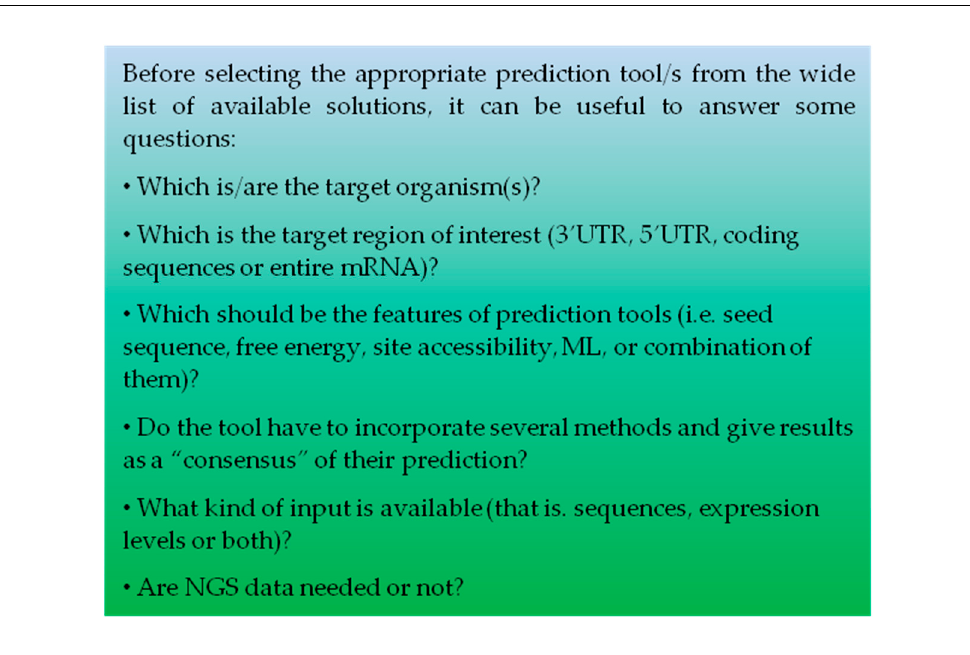
Figure 4. Stepwise strategy for miRNA target prediction. 1) Assessment of complementarity be- tween miRNA and 3 ′ -UTR target sequences. It is advisable to evaluate the score assigned to the prediction, to have an initial indication of its likelihood. 2) Evaluation of the free energy ( Δ G) of the interaction. This may give an indication of thermodynamic stability of the miRNA-mRNA interac- tion and further strengthen predictions. 3) Estimate of the evolutionary conservation of the miRNA target across the species. The more conserved a sequence of DNA, the higher the probability that it corresponds to functional, transcribed, RNA sequences. 4) Assessment of target site accessibility. This may provide a ranking of potential target sites. 5) Estimate of the number of target sites on the same 3 ′ -UTR. The use of multitargeting-based algorithms significantly decreases the number of predicted targets, and raise the chance of identifying true targets. 6) Comparison/Integration with results obtained from Machine Learning (ML) approach. This allows limiting the number of false positive and increasing the strength of the